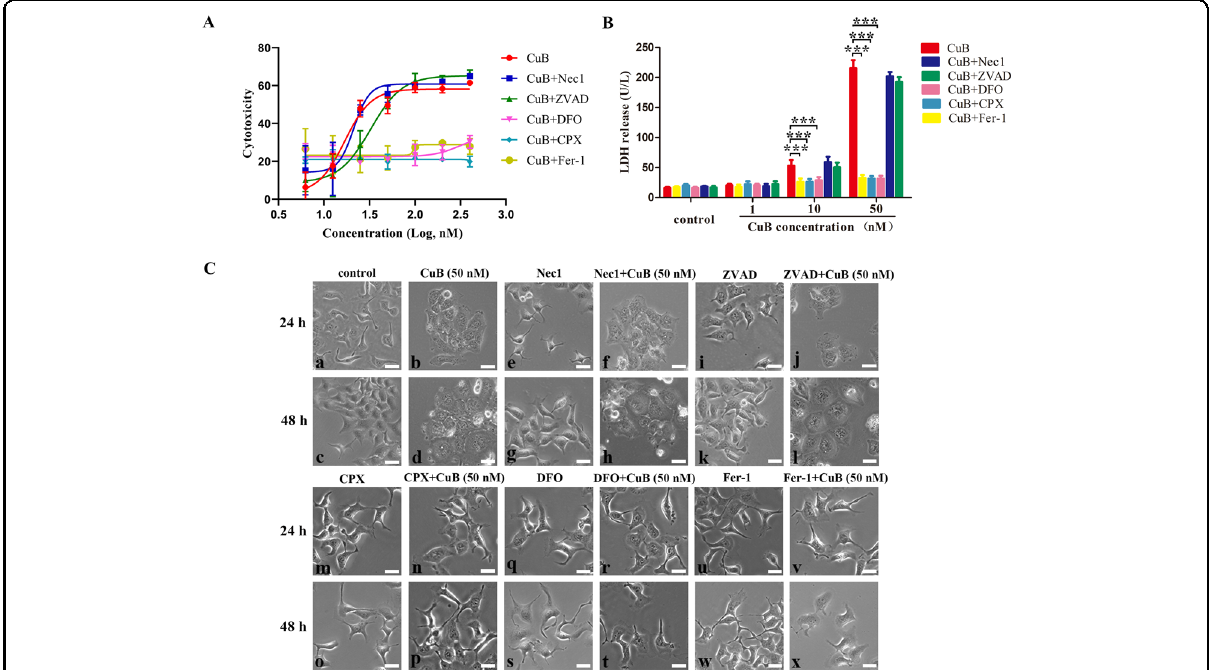
Fig. 3 CuB induced cell death of CNE1 cells. A The cytotoxicity of CuB at the concentrations of 6.25, 12.5, 25, 50, 100, 200, and 400 nM towards CNE1 cells with or without Nec1 (50 μ M), ZVAD (50 μ M), Fer-1 (5 μ M), CPX (5 μ M), or DFO (100 μ M) for 48 h, respectively, and the cytotoxicity were determined by MTT assay. B The LDH released in CNE1 cells exposed to CuB at the concentrations of 1, 10, and 50 nM with or without Nec1(50 μ M), ZVAD(50 μ M), Fer-1(5 μ M), CPX (5 μ M), or DFO (100 μ M) for 24 h, respectively. *** p < 0.001 vs . the CuB-treated group by t-test using GraphPad Prism 5.0. C Representative phase-contrast images of the CNE1 cells exposed to CuB at 50 nM for 24 h ( b ) and 48 h ( d ) with or without Nec1(50 μ M, e – h ), ZVAD(50 μ M, i – l ), CPX (5 μ M, m – p ), DFO (100 μ M, q – t ) or Fer-1(5 μ M, u – x ) by electron microscope (Nikon, Japan). Scar bar: 20 μ m. Data were presented as the mean ± SEM of three independent